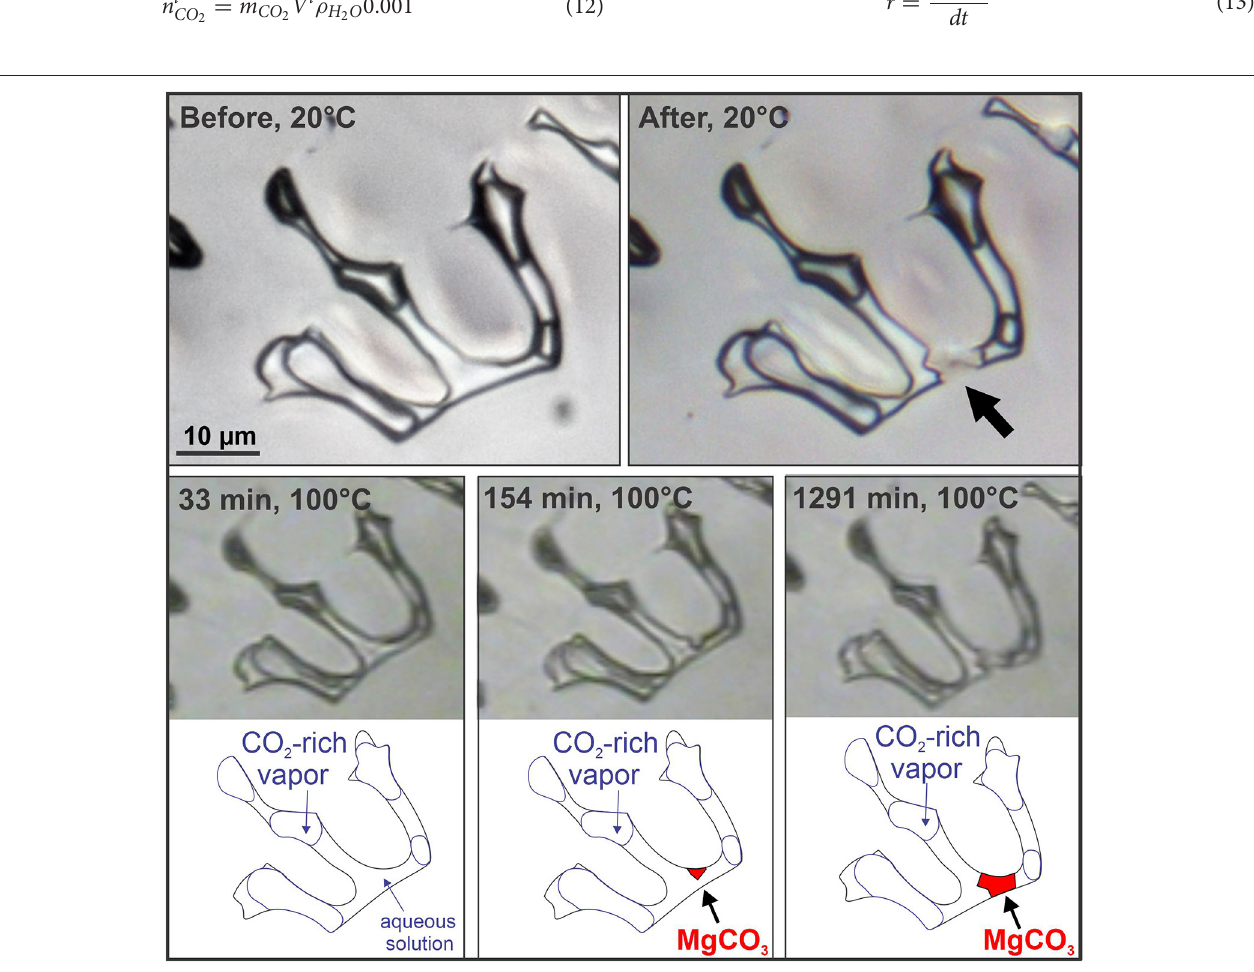
FIGURE 3 | Photomicrographs of a large, irregularly-shaped fluid inclusion from sample 11-4-16_IV taken at various stages during the carbonation reaction. The photos taken at room temperature before and after the experiment show the precipitation of magnesite (arrow on the right). Photos taken during the experiment at 100 ◦ C and schematic drawings of the inclusion at each time step (33, 154, and 1,291min) emphasize the progress of magnesite formation and growth.